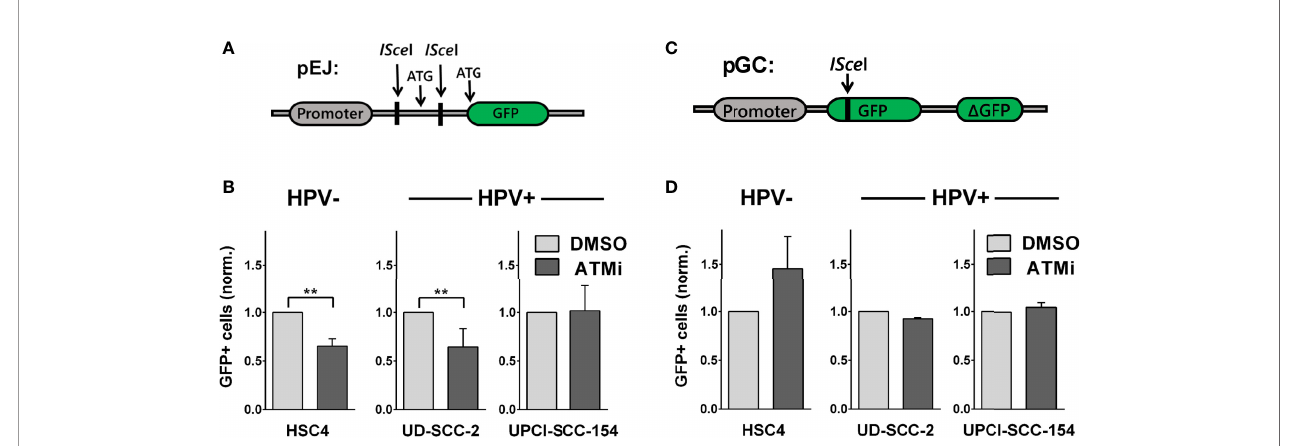
FIGURE 4 | Effect of ATM inhibition on DSB repair pathways. Reporter strains with stable integration of the respective repair constructs were transfected with an I-SceI expression vector. At 6 h and again at 24 h after transfection, the medium was exchanged and the inhibitor added. Forty-eight hours after transfection, the fraction of GFP-positive cells was assessed by fl ow cytometry. (A, C) Schemes of the NHEJ reporter construct pEJ and the HR reporter construct pGC. (B) Effect of ATM inhibition on NHEJ ef fi cacy and (D) on HR ef fi cacy. Results were normalized to the respective solvent controls of the individual experiments. Statistical evaluation was performed for changes upon ATM inhibition. Asterisks depict signi fi cant differences, with ** indicating p < 0.01 (two-tailed Student ’ s